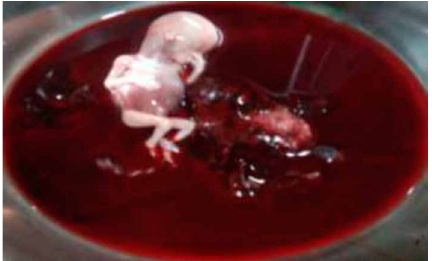
Figure 1: Dead male fetus and placenta removed from the peritoneal cavity.